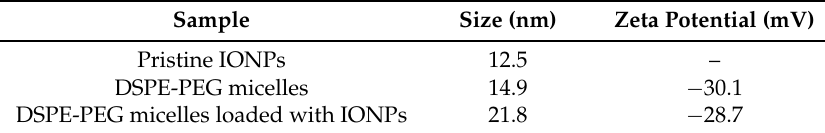
Table 1. Size and zeta potential of the IONPs-PM.